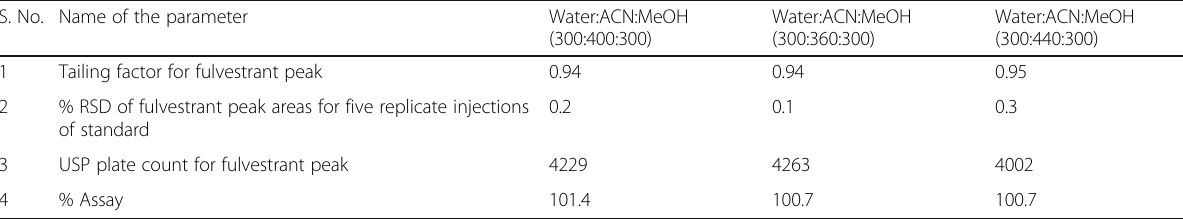
Table 10 Results of effect of variation in organic (acetonitrile) variation S. No. Name of the parameter